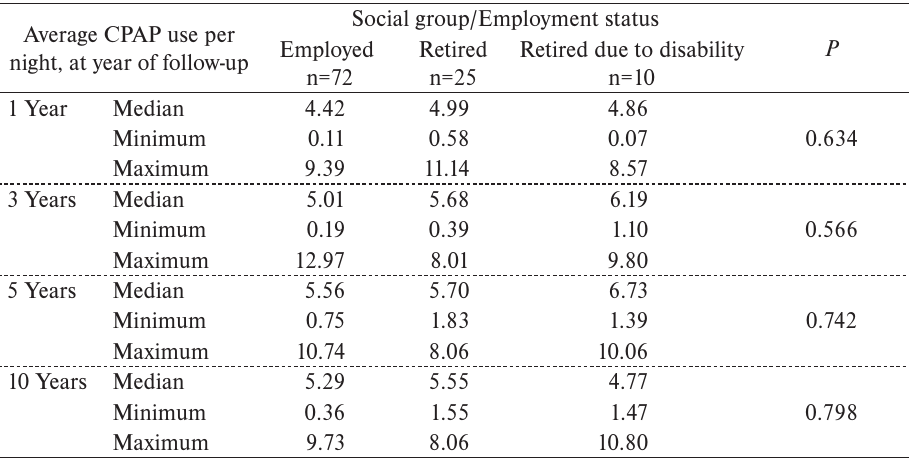
Table 2. CPAP adherence in different social groups – employed, retired, and retired due to